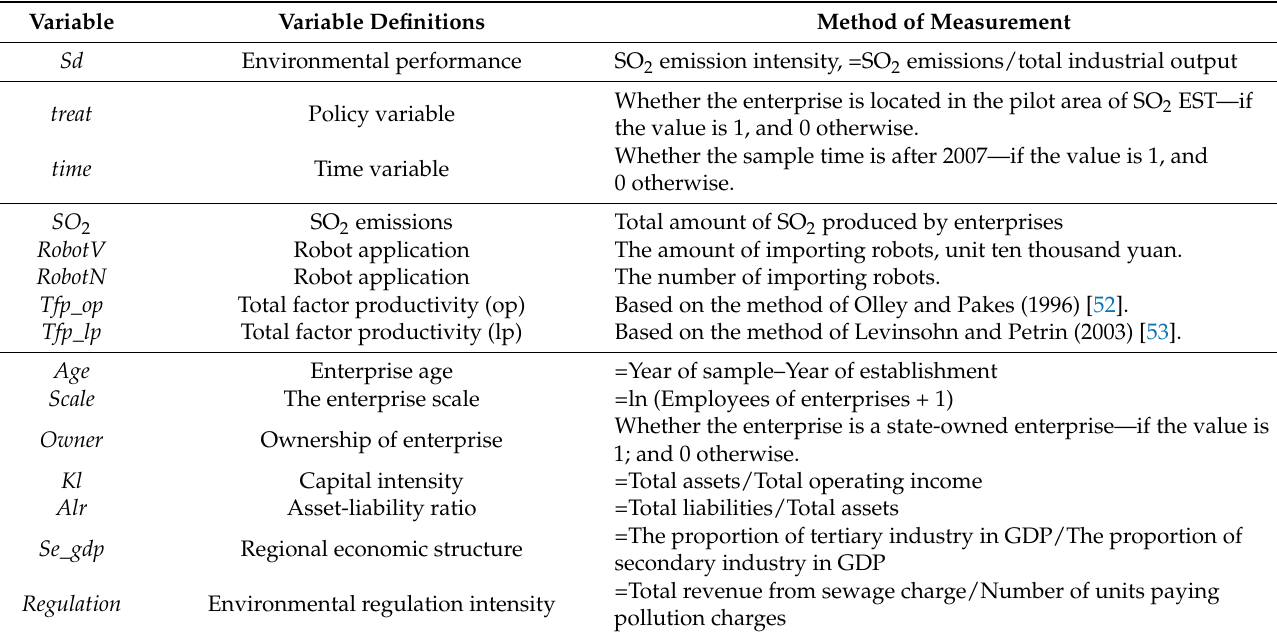
Table 1. Definition and measurement of